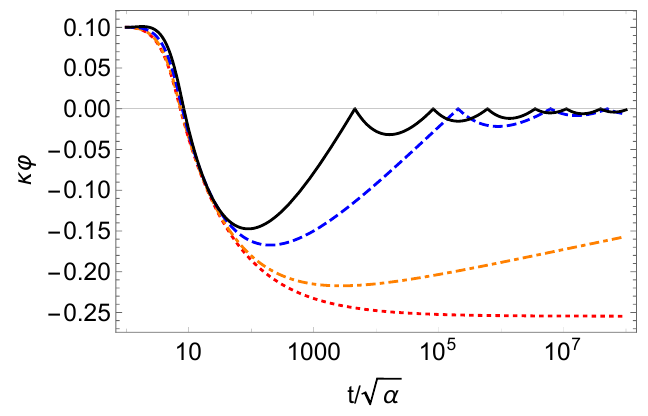
p (cid:11) for (cid:24) = 0 : 1 (solid